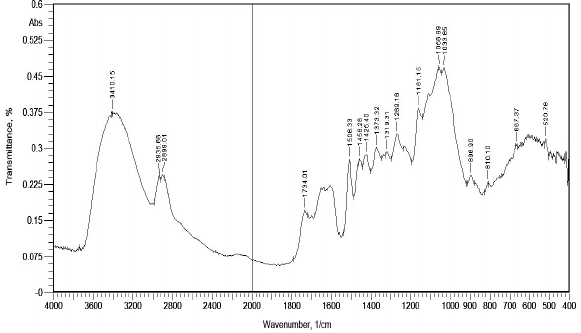
Fig. 1. The FTIR spectra of pine wood waste Table 2. Functional groups and the modes of vibrations of various peaks Adsorption Functional group with band (cm -1 ) mode of vibration